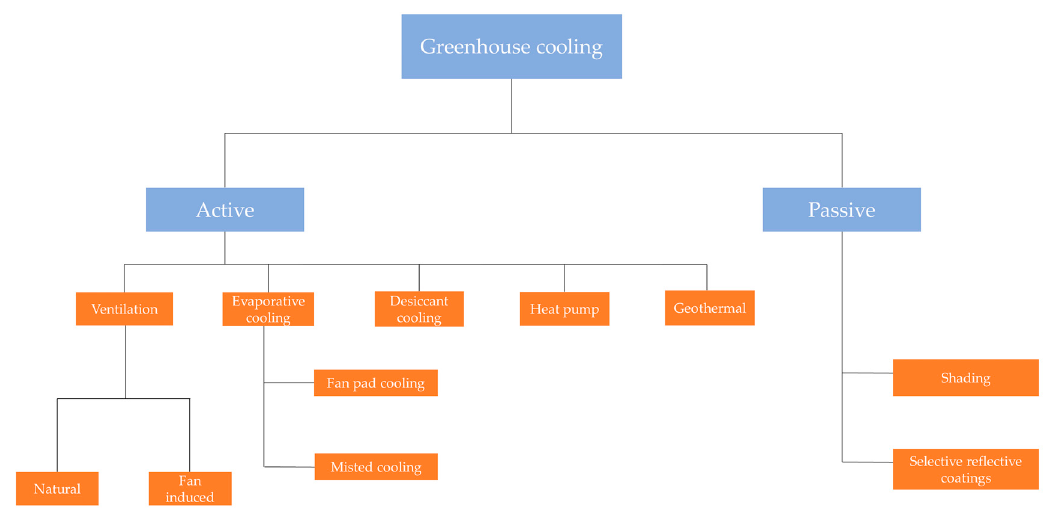
Figure 2. Active and passive cooling options for green houses and plant